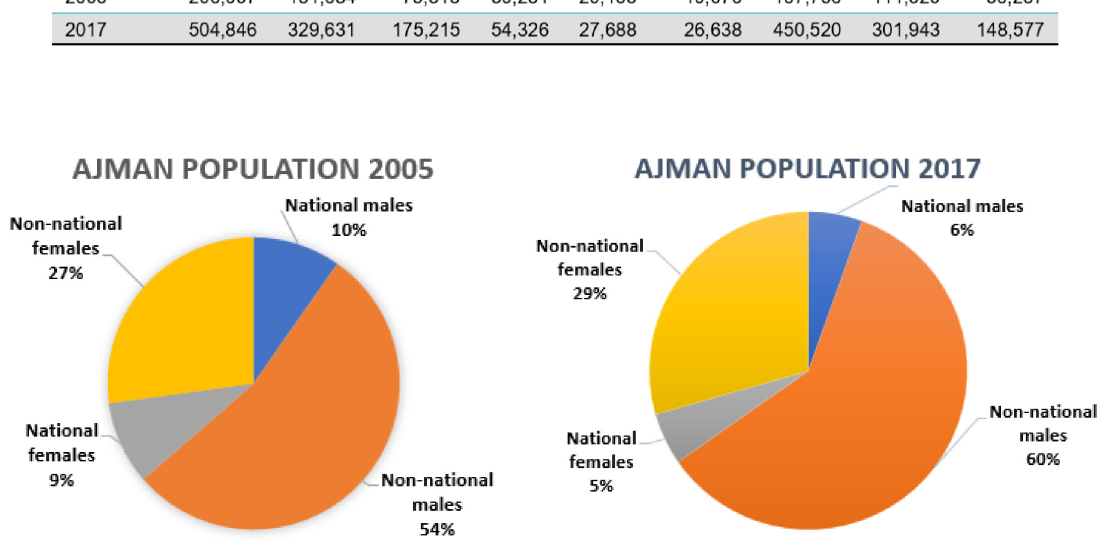
Fig. 1. Ajman population comparison 2005 and 2017 [4]